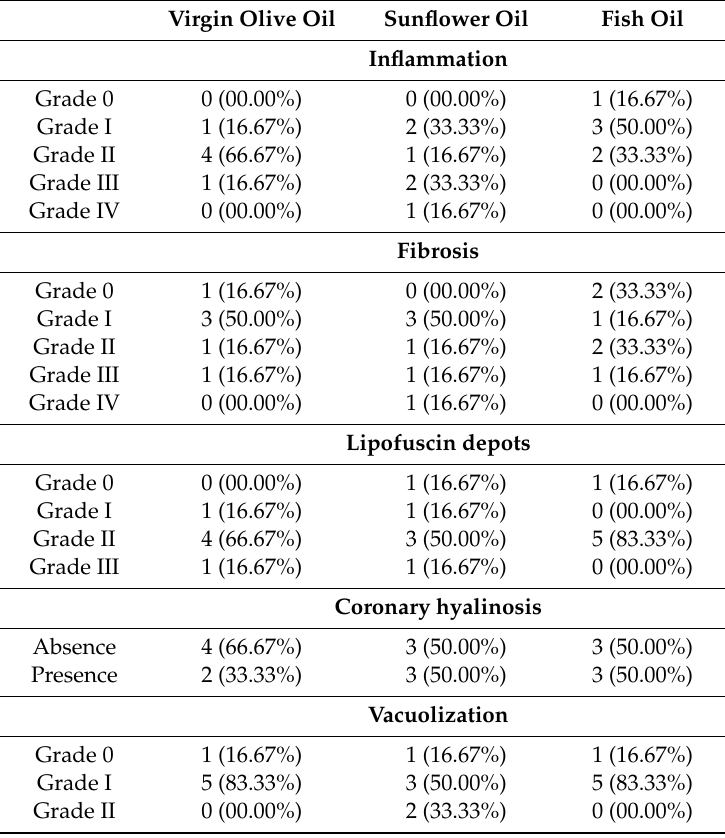
Table 3. Incidence (%) of di ff erent cardiac lesions of rats fed for 24 months on virgin olive oil, sunflower oil or fish oil ( n =